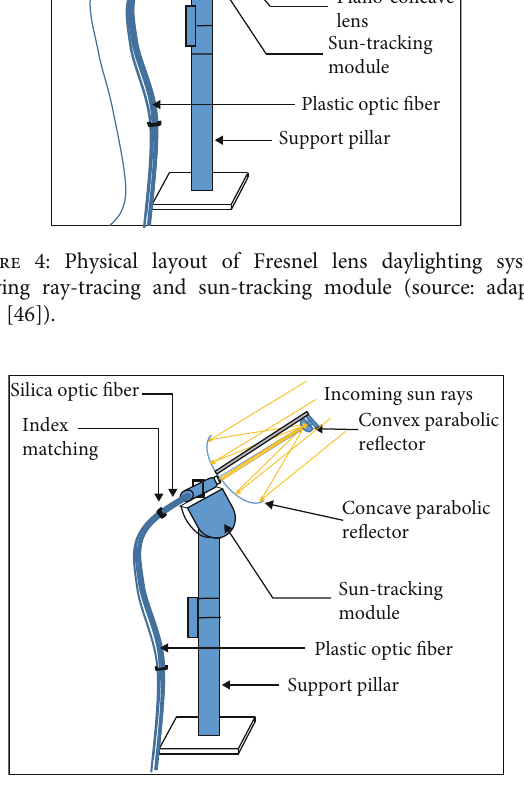
Figure 5: Physical layout of the parabolic mirror daylighting system showing ray-tracing and sun-tracking module (source: adapted from [46]).